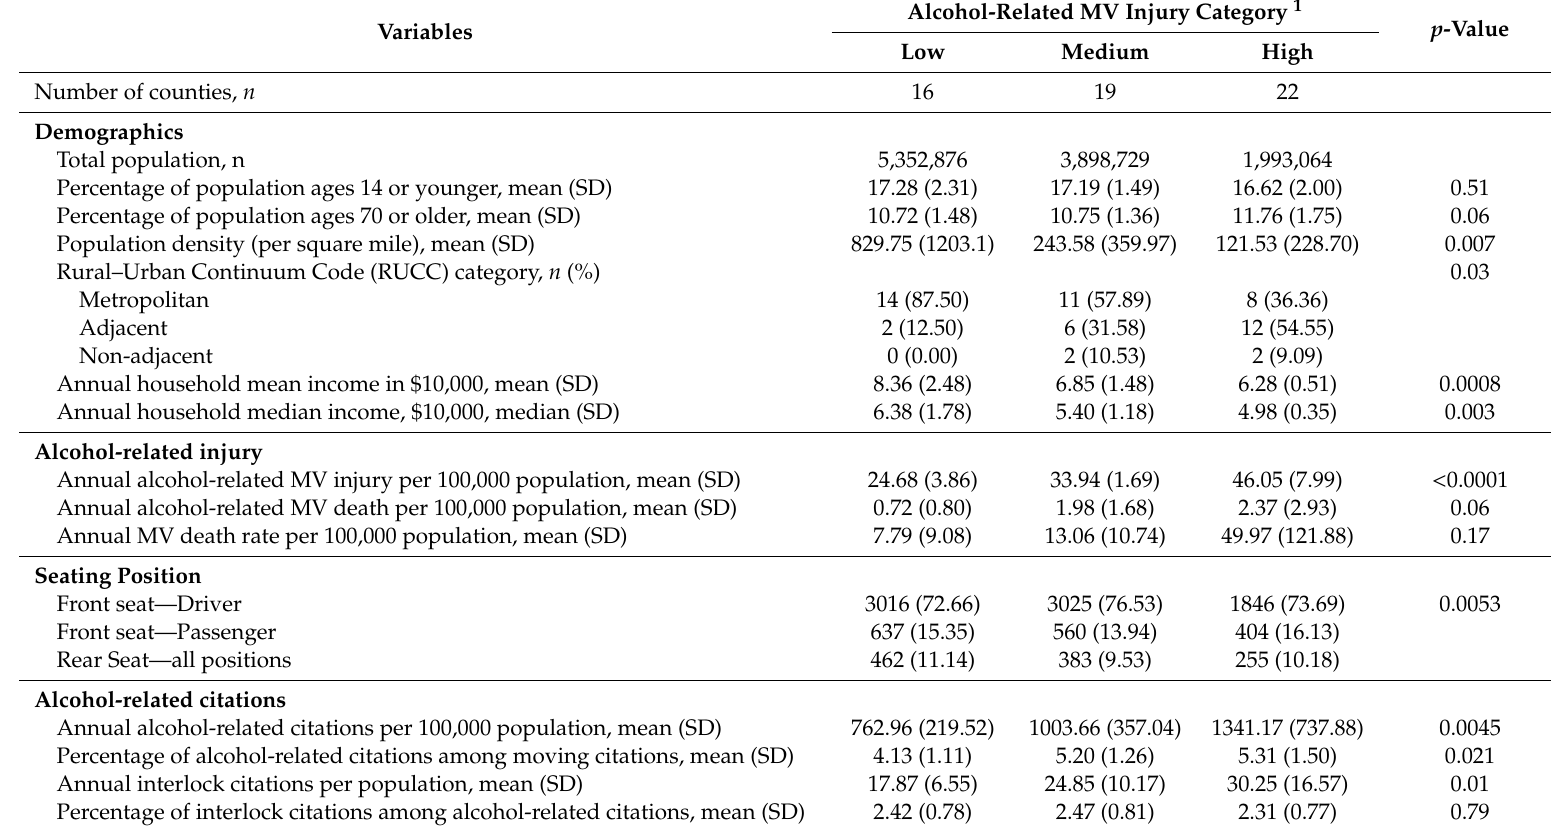
Table 1. County characteristics by alcohol-related motor vehicle (MV) injury